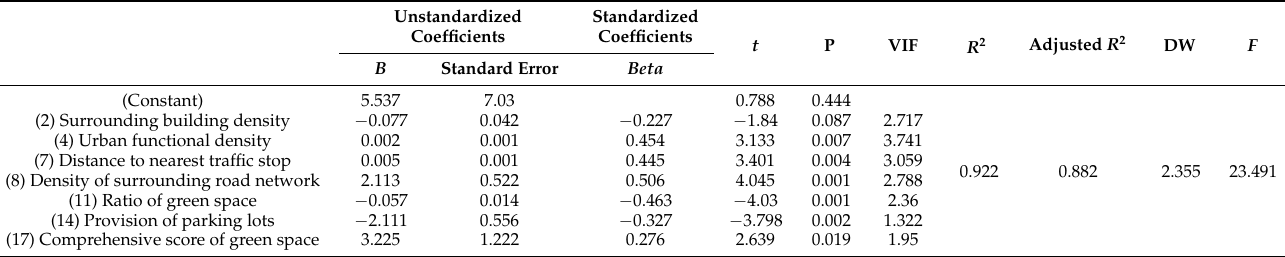
Table 3. Results of the regression